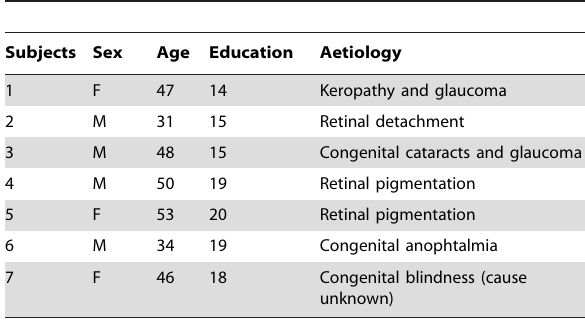
Table 1. Description of completely blind subjects (CBS; Experiment 1).